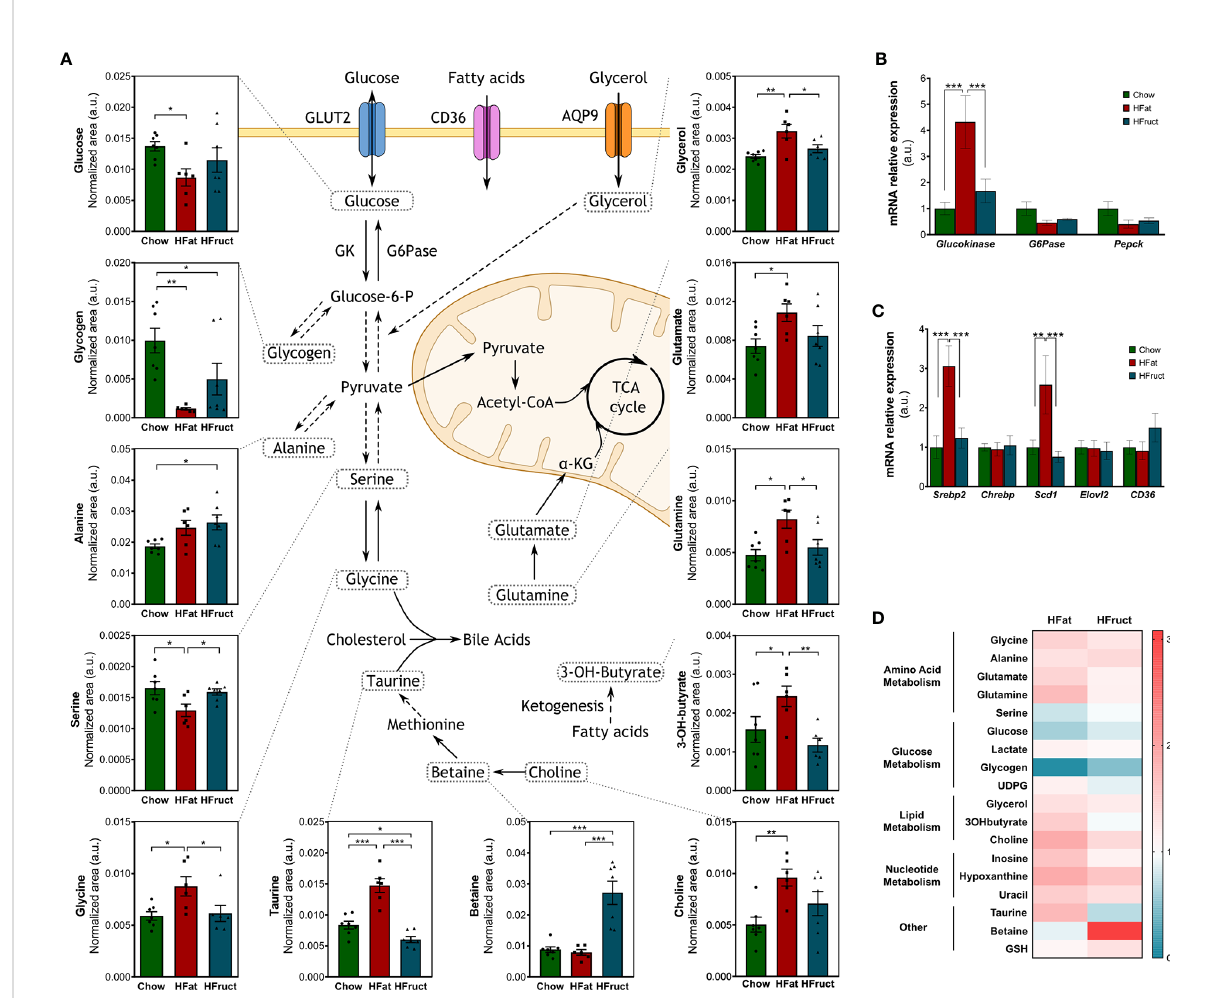
FIGURE 2 Effects of the HFat and HFruct diets on the hepatic metabolism of C57Bl/6J male mice. Chow, high-fat (HFat), and high-fructose (HFruct) hepatic levels of metabolites involved in glycolysis/gluconeogenesis, amino acid metabolism, ketogenesis, bile acid synthesis, and methionine cycle (A) , mRNA levels of glucose (B) , and lipid-related metabolism genes (C) , and heat map of hepatic polar metabolites in comparison to Chow metabolites, which are represented by 1/white (D) . a -KG, a -ketoglutarate; AQP9, aquaporin 9; CD36, cluster of differentiation 36; G6Pase, glucose-6-phosphatase; GK, glucokinase; GSH, glutathione; TCA, tricarboxylic acid; UDPG, uridine diphosphate glucose. Data are presented as mean ± SEM for fi ve to seven mice. *p<0.05, **p<0.01;